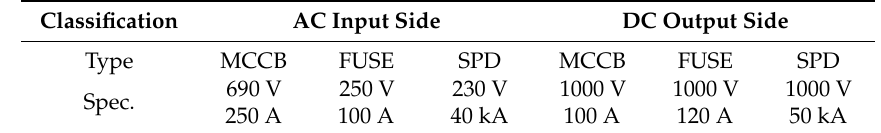
Table 2. Protection elements in the AC/DC power converter.